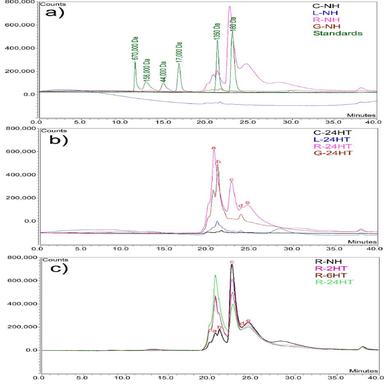
Size exclusion chromatogram of a) nonheated (NH)- and b) heat-treated (HT)-films (five detected peaks were labelled as a, b, c, d and e) hydrolysates as a function of saccharide (glucose (G), lactose (L), and ribose (R)); and c) R-films (five detected peaks were labelled as a, b, c, d and e) as a function of heating time (NH and HT for 2, 6, and 24 h) detected at excitation of 320 nm and emission of 385 nm. The standard was measured at 254 nm which contained thyroglobulin 670,00 Da, γ-globulin 158,000 Da,